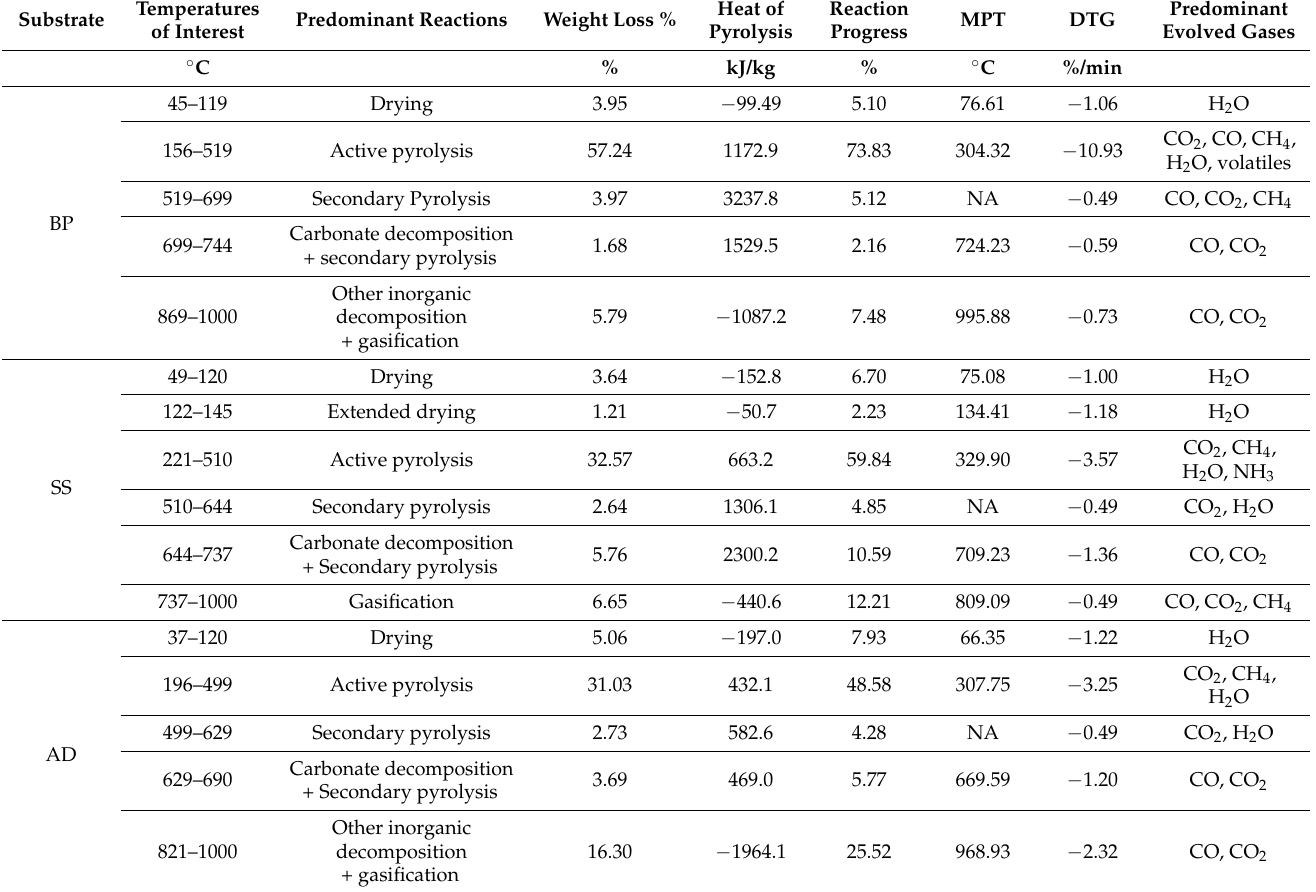
Figure 8. Normalized evolved gas analysis (EGA) during the pyrolysis of BP, SS and AD with HTT 745, 735, and 690 °C, respectively.